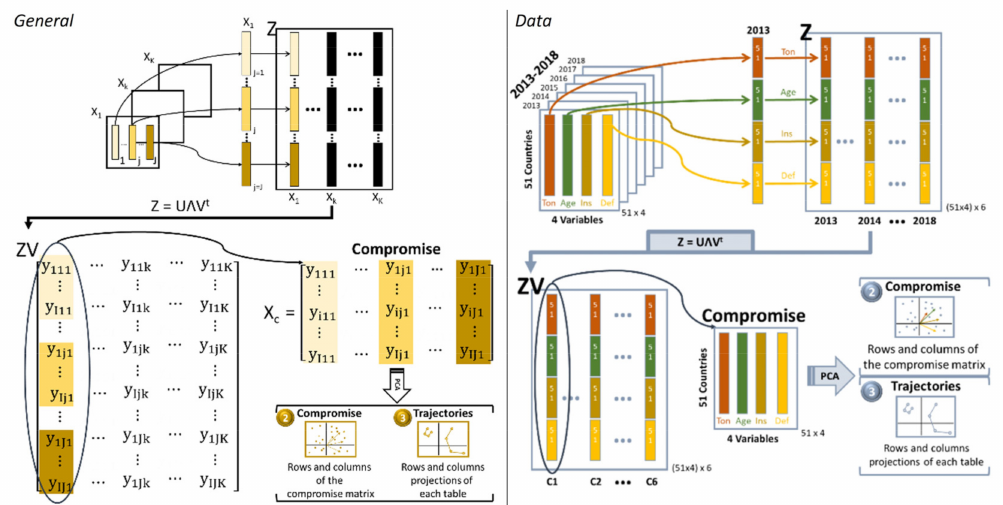
Figure 2. Compromise analysis flow chart in